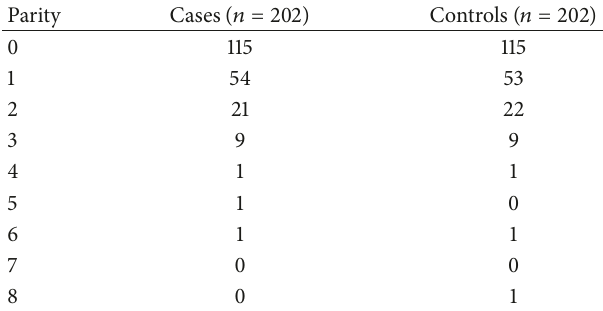
Table 3: Distribution of parity across cases and controls.